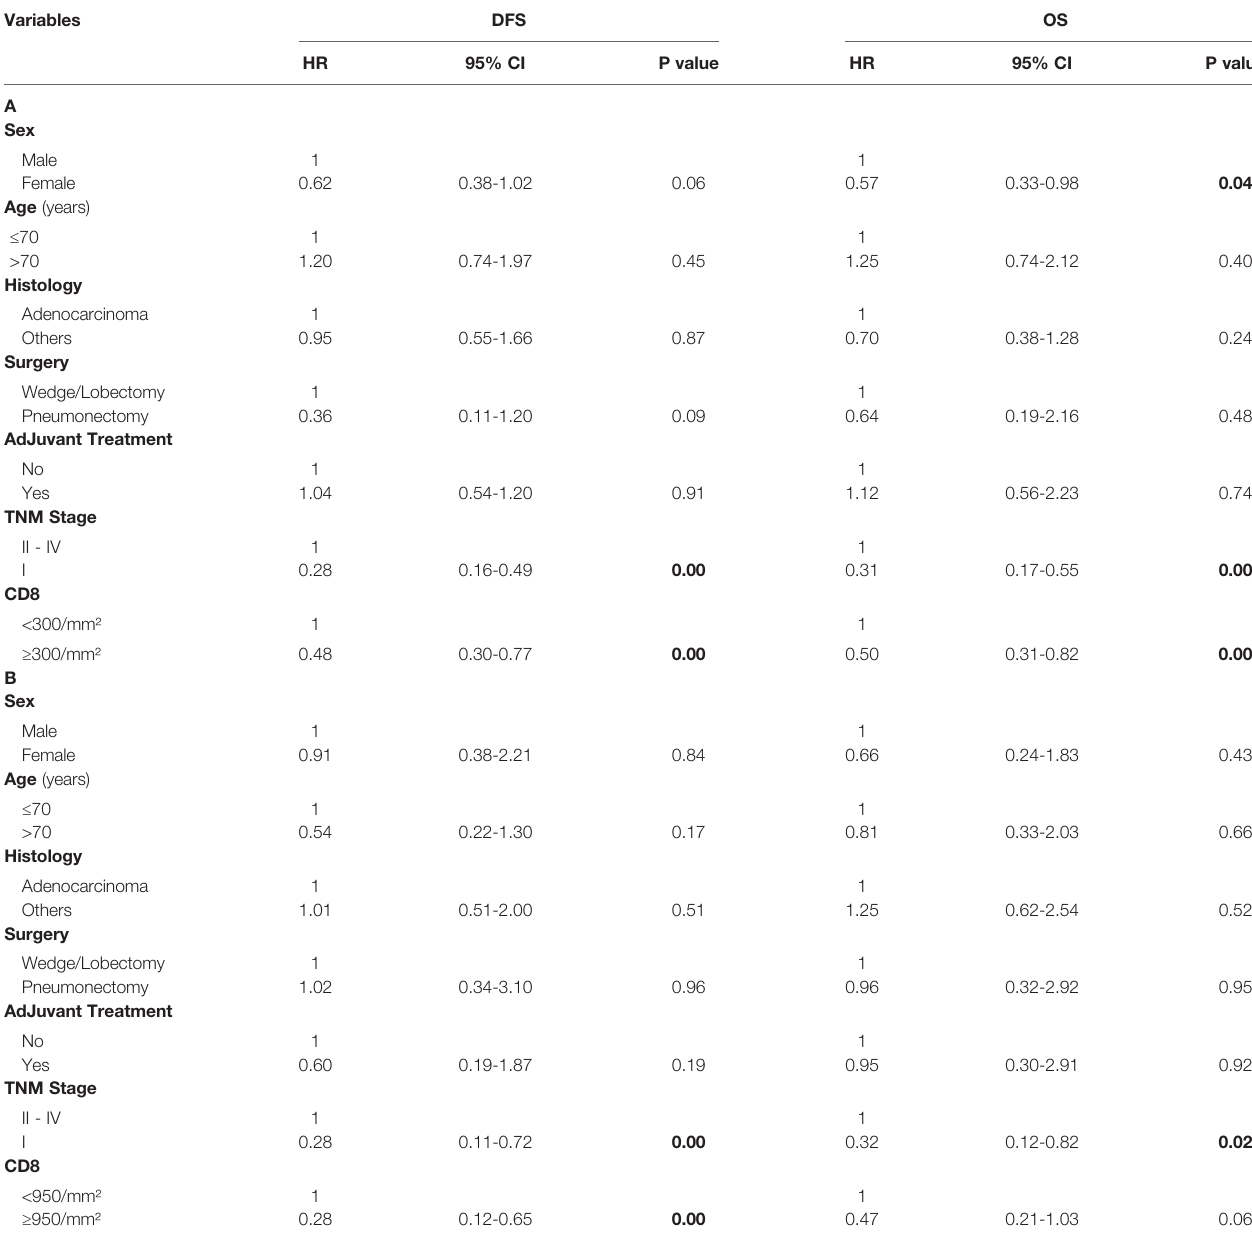
TABLE 3 | Multivariate analysis of predictors of DFS and OS in PD-L1 negative NSCLC using the 25 th percentile of CD8 + TILs (A) and in PD-L1 positive NSCLC using the 75 th percentile of CD8 + TILs as threshold (B) . Variables